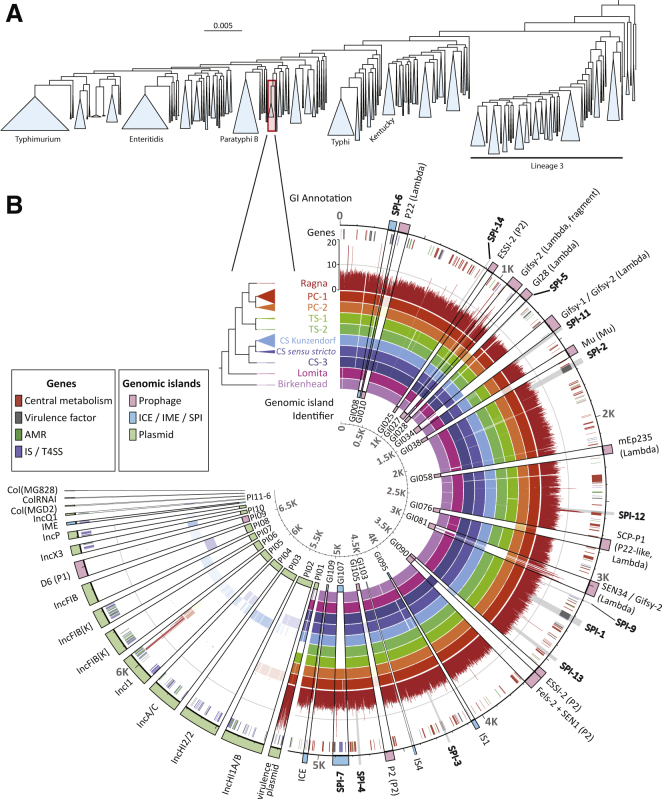
Genomic Phylogenies of Salmonella enterica and the Para C Lineage(A) Maximum-likelihood phylogeny of 2,964 representative genomes of S. enterica subspecies enterica. Each genome is a representative of one ribosomal multi-locus sequence typing (rMLST) sequence type. Blue triangles indicate common lineages containing numerous genomes, including the Para C lineage. Several lineages are associated with common serovars, as indicated by horizontal labels. Red rectangle: Para C lineage plus the outgroup Birkenhead.(B) Pan-genomic contents for 6,665 pan-genes in 222 genomes of the Para C lineage, including Ragna, plus Birkenhead, with one stroke per gene. Circles (inner to outer); Circle 1: sixteen major, variably present chromosomal genomic islands (GI008–GI109) followed by sixteen cytoplasmic plasmids, circular phages plus one IME (PI01–PI16), color-coded as in the genomic islands key. Circles 2–10: the frequency of presence or absence of each gene per sub-lineage within the phylogram is indicated by color opacity. Circle 11: coverage of aDNA reads per gene within Ragna (scale 0–20 reads at 12:00). Circle 12: genes color-coded as in the genes key. Circle 13: traditional designations for GIs, PIs, and other variably present genomic elements (Table S3). Gray wedges: SPIs.See also Table S1 for summary statistics on the sources and dates of collection of the bacterial strains and Table S5 for the metadata for each individual genome.